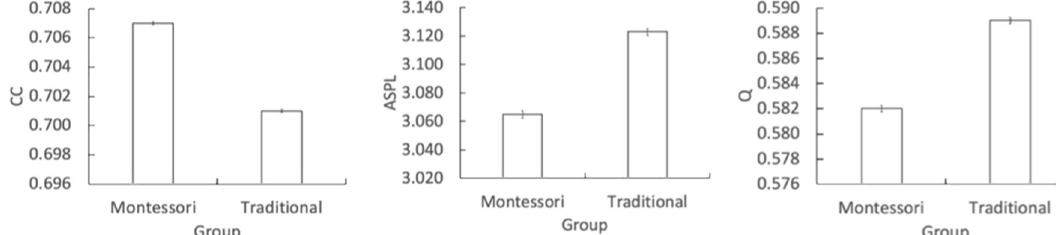
Fig. 2 Case-wise bootstrapping analysis for the Montessori and traditional groups. Clustering coef fi cient (CC, left), average shortest path length (ASPL, center), and modularity (Q, right). X -axis: school group; Y -axis: dependent variables (CC, ASPL, and Q; error bars denote standard error). The range of scores on the different Y -axes are measure-speci fi c and should not be compared across measures. Furthermore, the Y -axes across the three measures do not start at zero as to clarify the difference in measures across the two groups.